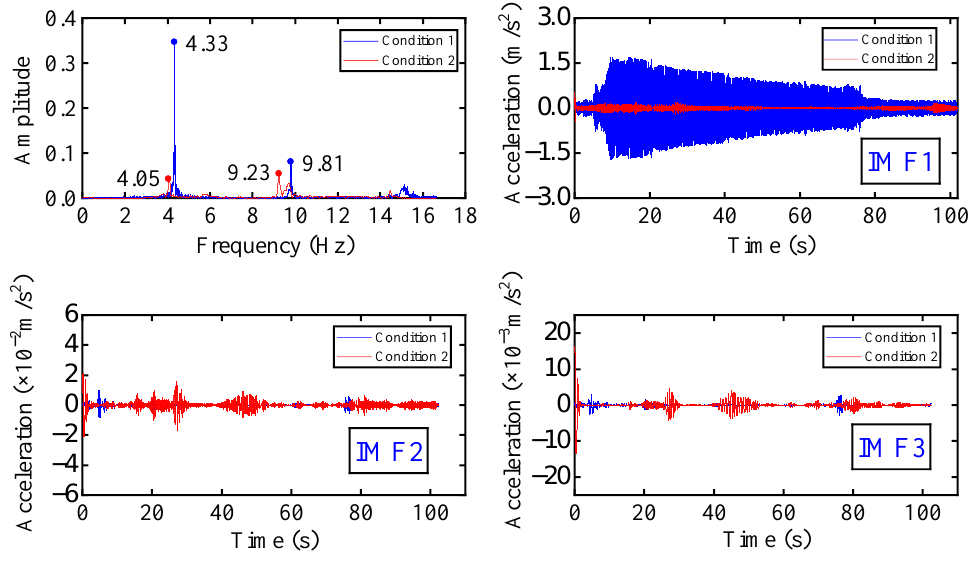
Figure 4. Conditions 1 and 2 of scale model experiment: the fast Fourier transform and variational mode decomposition (VMD) decomposition results.